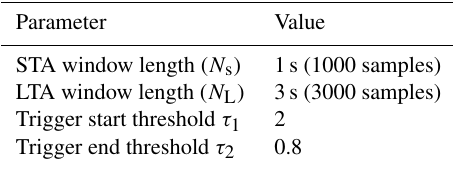
Table 2. Parameters used for the STA/LTA detection